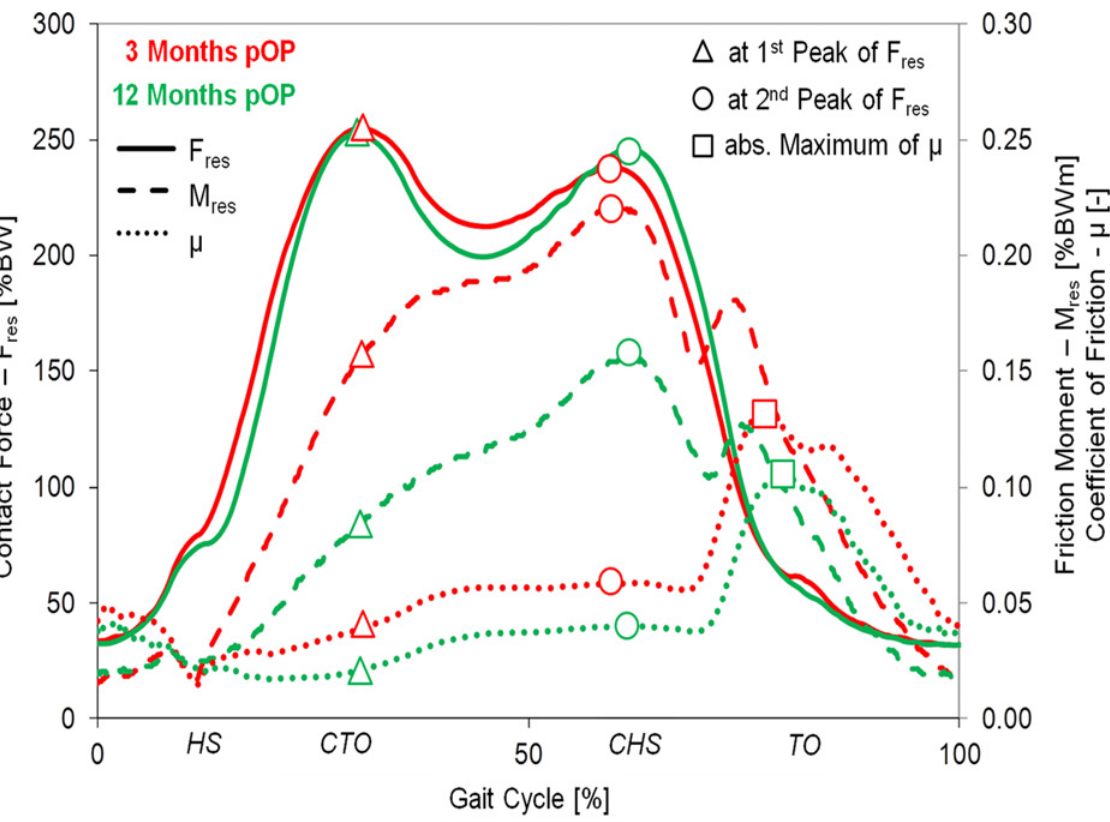
Fig 2. Postoperative changes of loads and friction. Average time courses of F res , M res and μ during one gait cycle at three and twelve months pOP. The indicated values M res1 , M res2 , μ 1 , μ 2 and μ max were determined at the instants of the peak forces F res1 and F res2